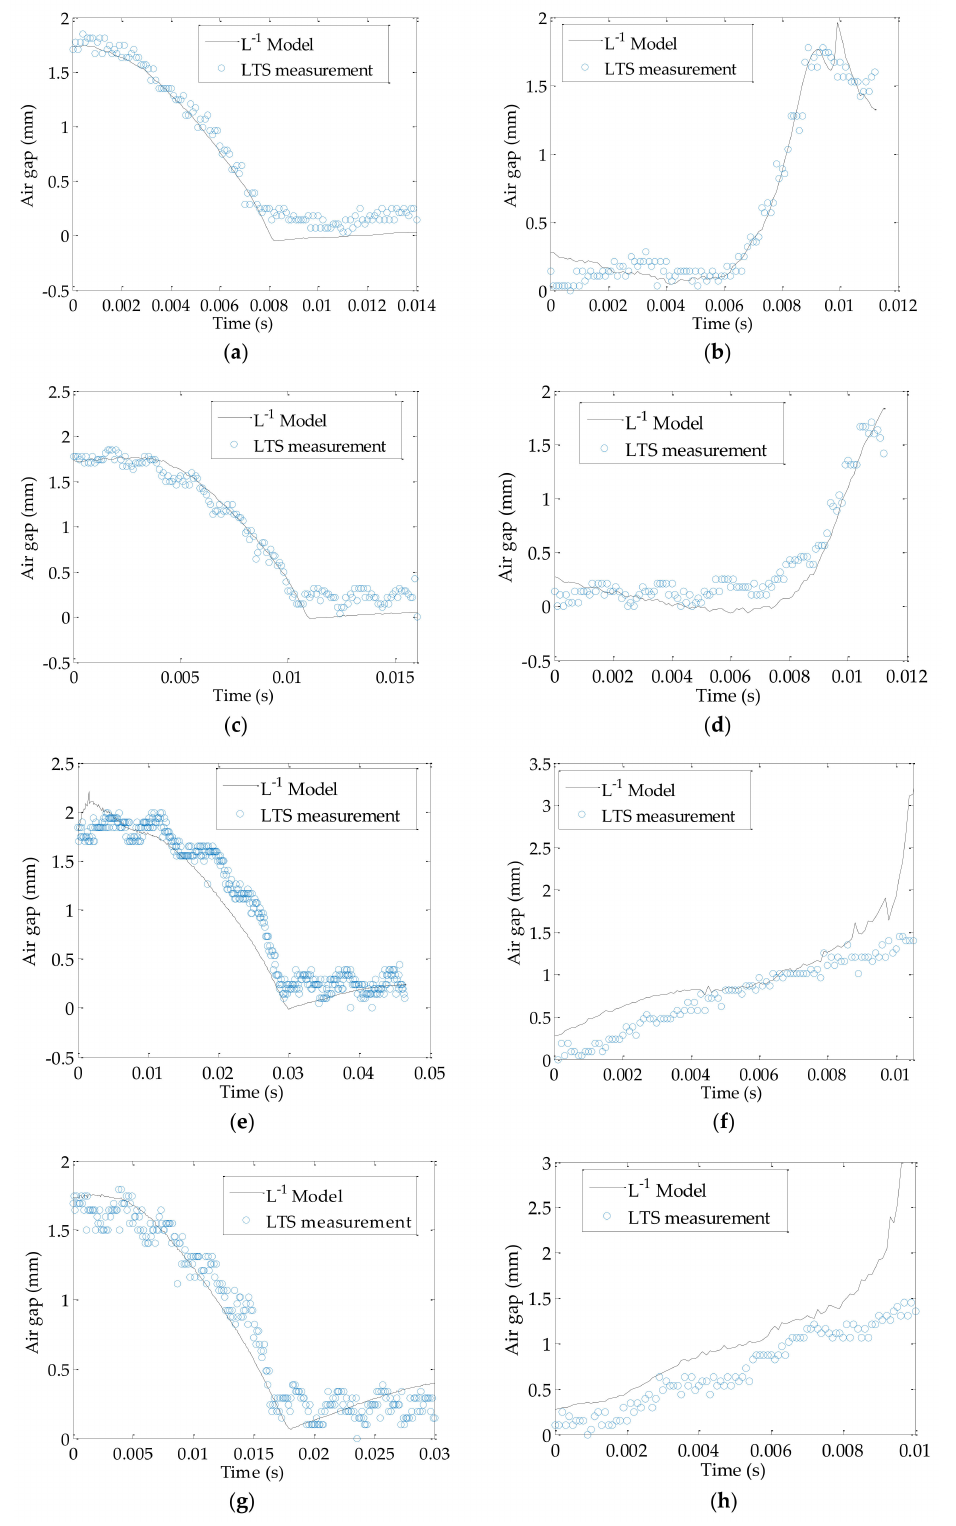
Figure 10. Performance of the model: ( a ) Valve is energized (air gap decreasing) in atmosphere under 25.6 V; ( b ) Valve is deenergized (air gap increasing) in atmosphere from 25.6 V; ( c ) Valve is energized in atmosphere under 23.5 V; ( d ) Valve is deenergized in atmosphere from 23.5 V; ( e ) Valve is energized in hydraulic oil under 26.3 V; ( f ) Valve is deenergized in hydraulic oil from 26.3 V; ( g ) Valve is energized in hydraulic oil under 29.0 V; ( h ) Valve is deenergized in hydraulic oil from 29.0